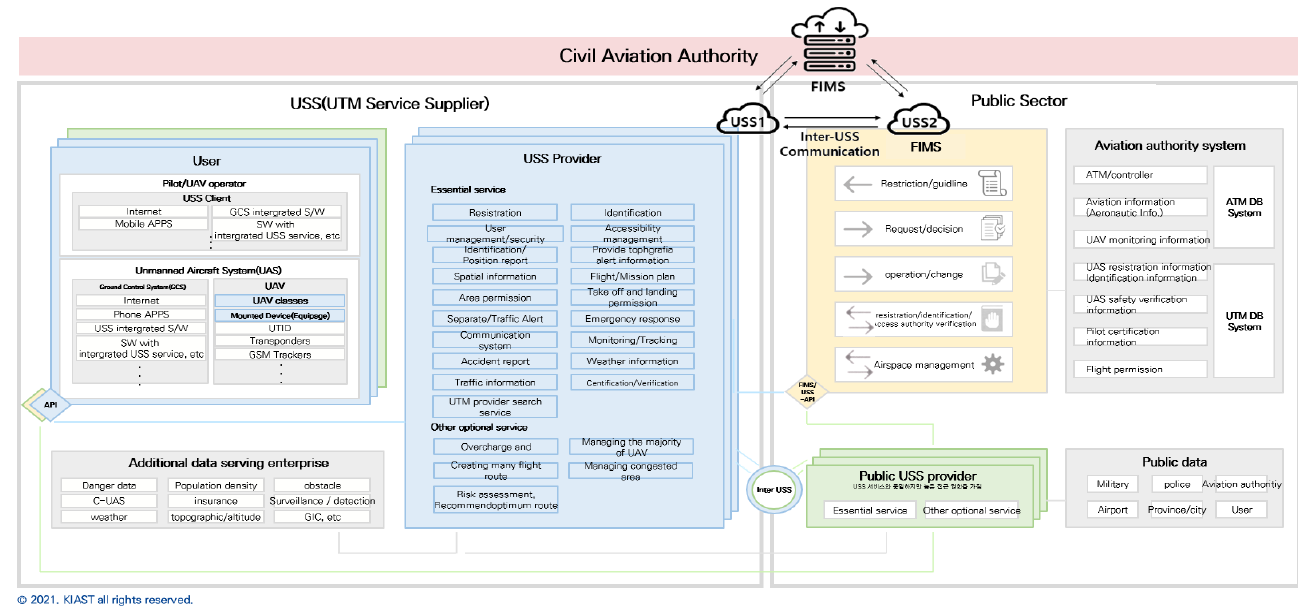
Figure 2. Korea UTM Architecture.